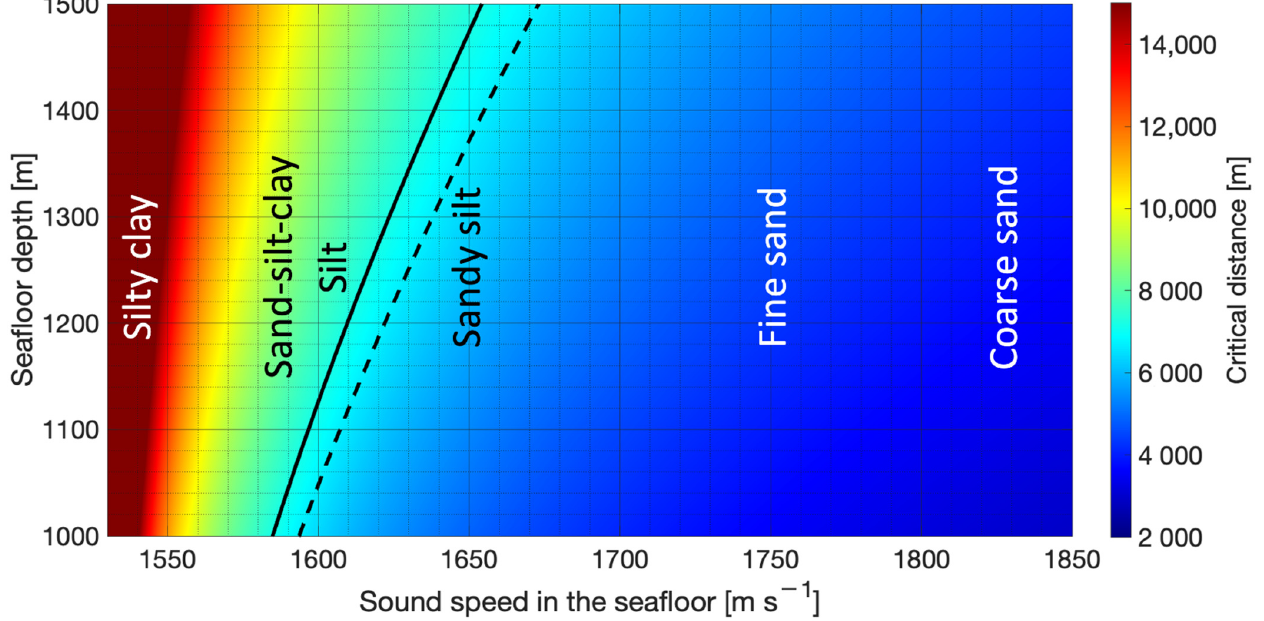
Figure 5. The critical distance R c as a function of bottom depth H 1 and sound speed at the seafloor c 0 calculated with Equation (2) for the sound speed in water c w = 1527 m s − 1 (color scale). This critical distance determines the minimum lengths of an HLA that would be required to record the upwardly traveling seafloor interface head wave at the sea surface. Inversely, it defines the minimal seafloor velocities that can be defined with a given length of HLA, such as the 7.2 km-long cable used in this work (solid line). In practice, such a cable can only define higher minimal velocities, as some length would be required for an adequate identification of the arrivals. This extra distance is estimated in this work to be ~500 m (dashed line). Sound-speed values used for sediment classification in this figure are based on [45].